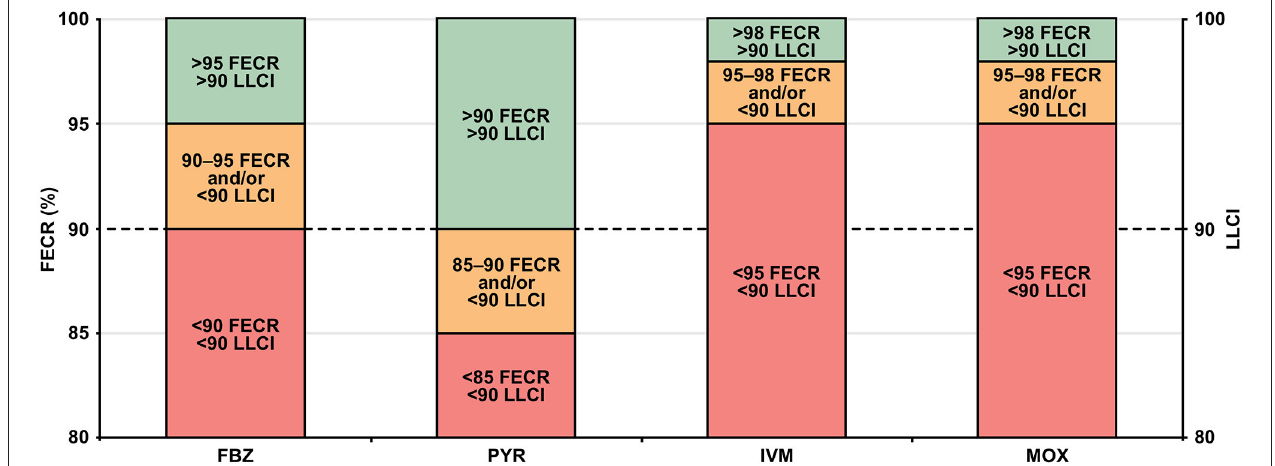
FIGURE 2 | Criteria for determining the efficacies of FBZ, PYR, IVM and MOX: FECR% (normal, green; suspected, orange; reduced, red) and 95% LLCI. FBZ, fenbendazole; FECR%, mean fecal egg count reduction; IVM, ivermectin; 95% LLCI, lower limit of the 95% credible interval; MOX, moxidectin; PYR, pyrantel embonate.